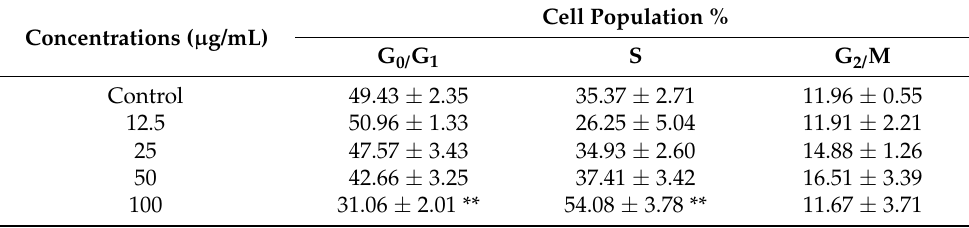
Table 2. Effects of C. ambrosioides essential oil on the cell cycle distribution of the L02 cells. Cell Population % Concentrations ( µ g/mL) G 0/ G 1 S G 2/ M Control 49.43 ± 2.35 35.37 ± 2.71 11.96 ± 0.55 12.5 50.96 ± 1.33 26.25 ± 5.04 11.91 ± 2.21 25 47.57 ± 3.43 34.93 ±